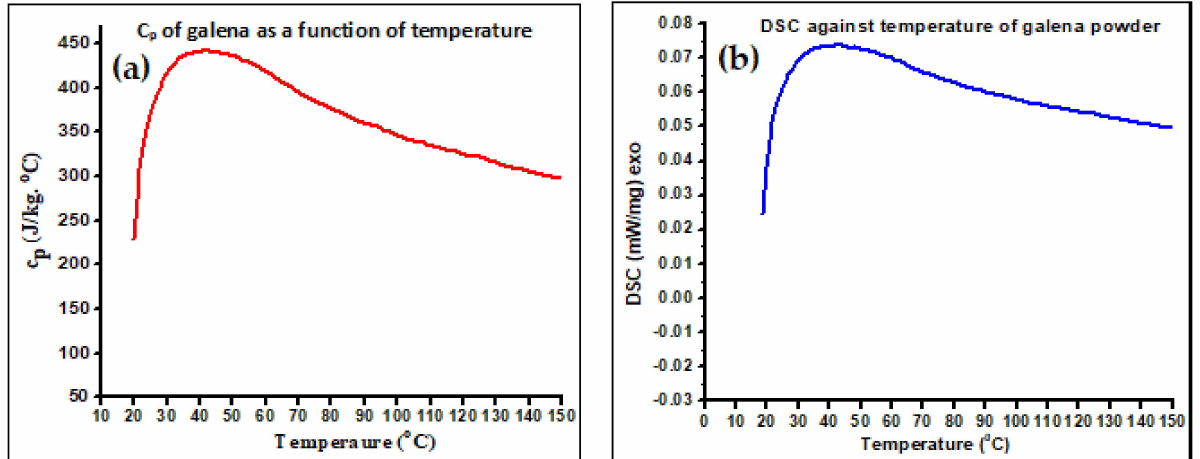
Figure 2. ( a ) The c p curve of the as-received galena ore against temperature. ( b ) DSC, heat flow per unit mass with temperature.